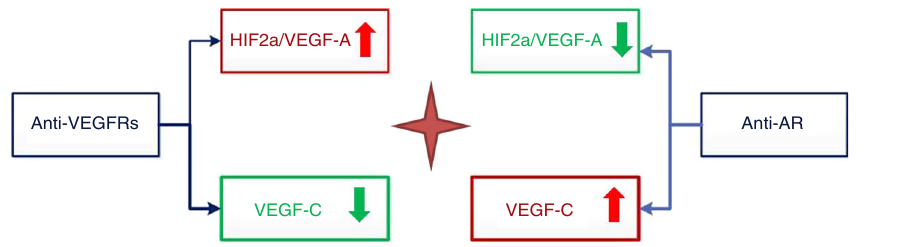
Fig. 9 Schematic illustration of AR ’ s role in RCC metastasis and therapy. a A schematic illustration of the proposed model that AR increases hematogenous metastasis yet decreases lymphatic metastasis of RCC. AR increases miR-185-5p by targeting its promoter. The miR-185-5p upregulates HIF2 α also by targeting the promoter and results in elevation of VEGF-A. However, miR-185-5p downregulates VEGF-C by targeting the 3 ′ UTR. b A schematic illustration of potential targeted therapeutic strategy of combining anti-VEGFR with